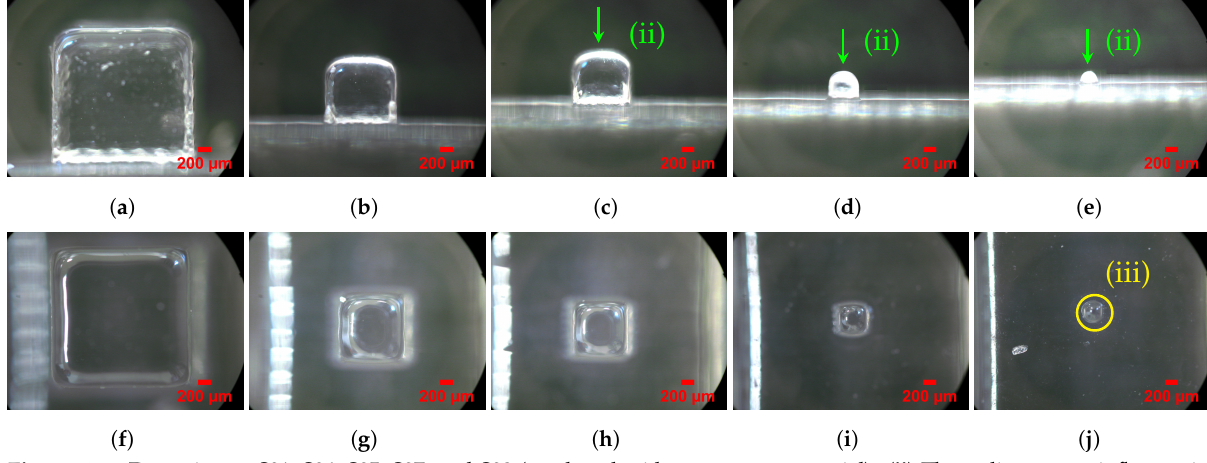
Figure 4. mD specimens S01, S04, S05, S07, and S08 (produced without support material). ( ii ) The radius corner influence in geometry deviations increases for small features. For dimensions smaller than S04 1058 µ m, ( b ) the top side became domed; ( iii ) for the size S08, the cube was distorted in cylindrical shape; ( a , f ) S01 side and top view; ( b , g ) S04 side and top view; ( c , h ) S05 side and top view; ( d , i ) S07 side and top view; ( e , j ) S08 side and top view. For details about the conditions of the images taken, see Section